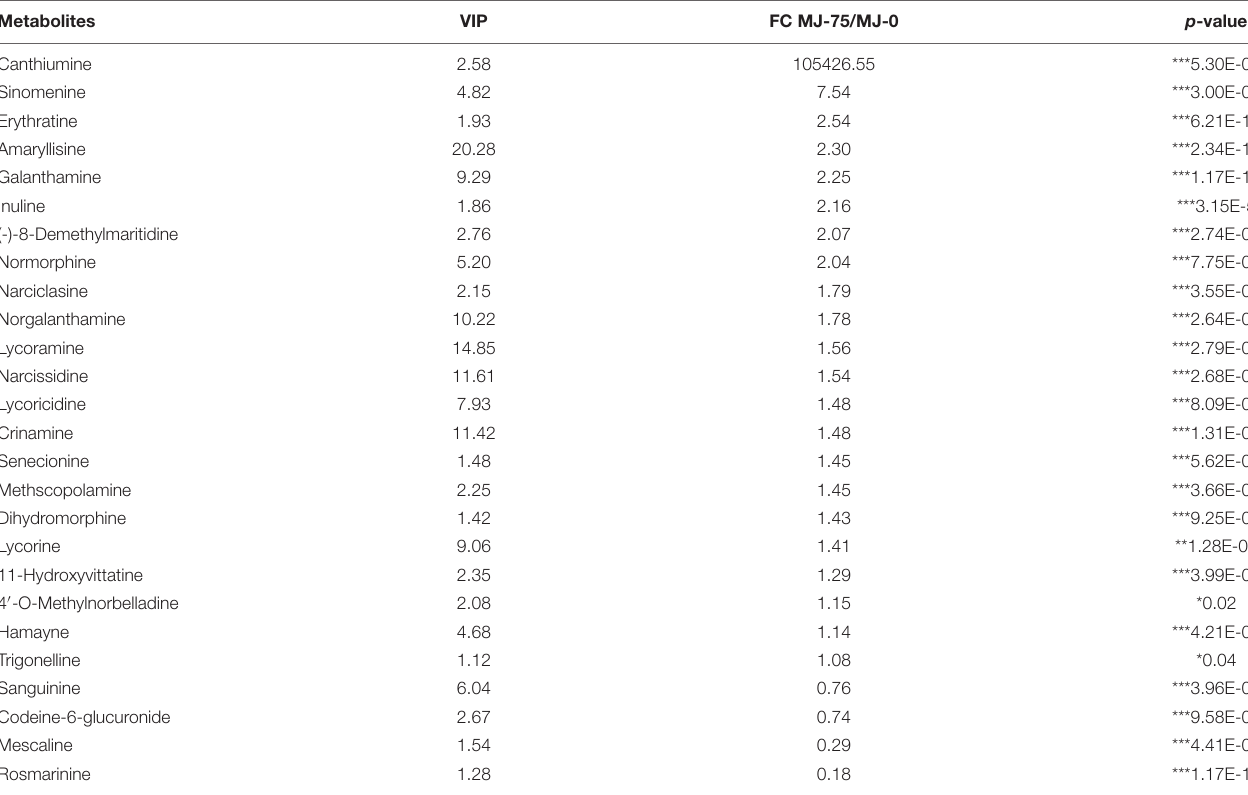
TABLE 1 | Differential alkaloids and derivatives identified from LC-MS in MJ-75 and MJ-0 treatment L. longituba seedlings ( N = 6). Metabolites VIP FC